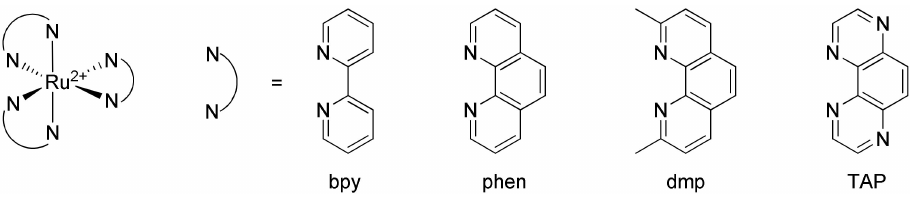
Figure 12. Schematic structure of ruthenium(II) polypyridyl complexes and of typical ancillary ligands.